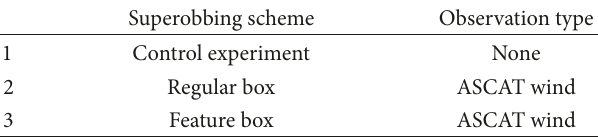
Table 2: Data assimilation experiment design.